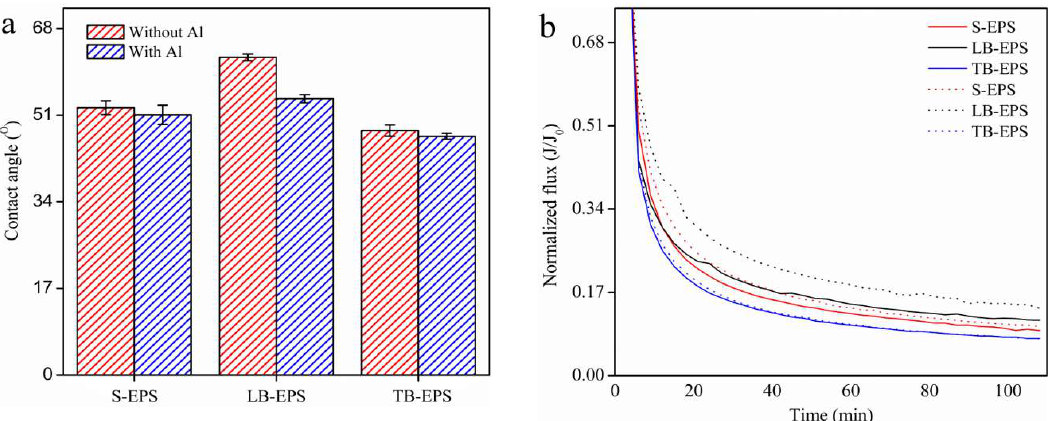
Figure 6. Contact angle of EPS fractions with and without aluminum ( a ) and normalized flux reduction of EPS fractions after being dissolved to the EPS concentration of 0.1 mg/L. Solid line represents the groups with Al, while dashed line represents the groups without Al ( b ).